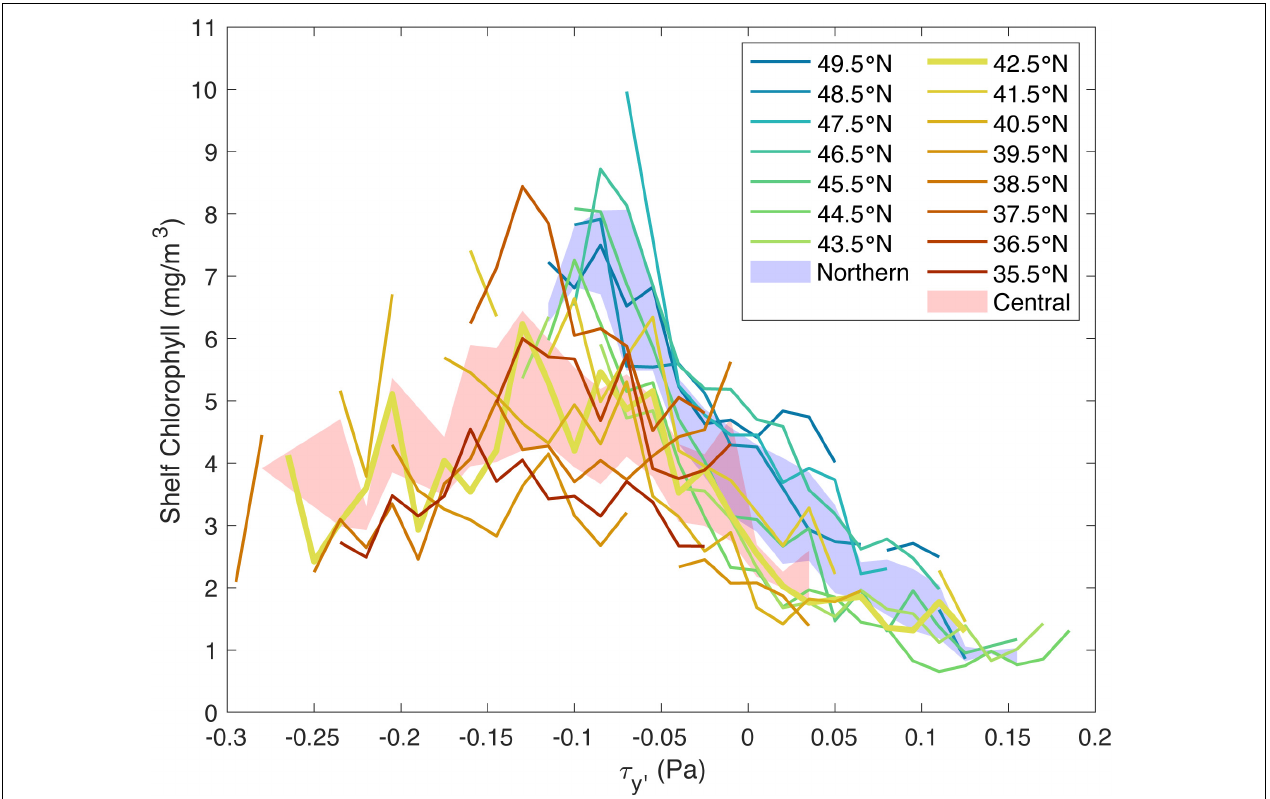
FIGURE 7 | Shelf chlorophyll concentration vs. wind stress bins for the entire domain (35.5–49.5 ◦ N) from 2000 to 2019, colored by latitude. Only bins whose difference between high and low 95% confidence intervals is less than the global shelf chlorophyll mean are included. Northern latitudes (43.5–49.5 ◦ N) are shown in cool colors, while Central latitudes (35.5–41.5 ◦ N) are shown in warm colors, with the dividing latitude (42.5 ◦ N) is shown in the thick yellow line. Mean chlorophyll concentration vs. wind stresses curves are plotted for the Central region (35.5–42.5 ◦ N; shaded red) and Northern region (43.5–49.5 ◦ N; shaded blue). These mean curves were calculated via the bootstrapping method in MATLAB and are plotted to depict the 95% confidence intervals for each